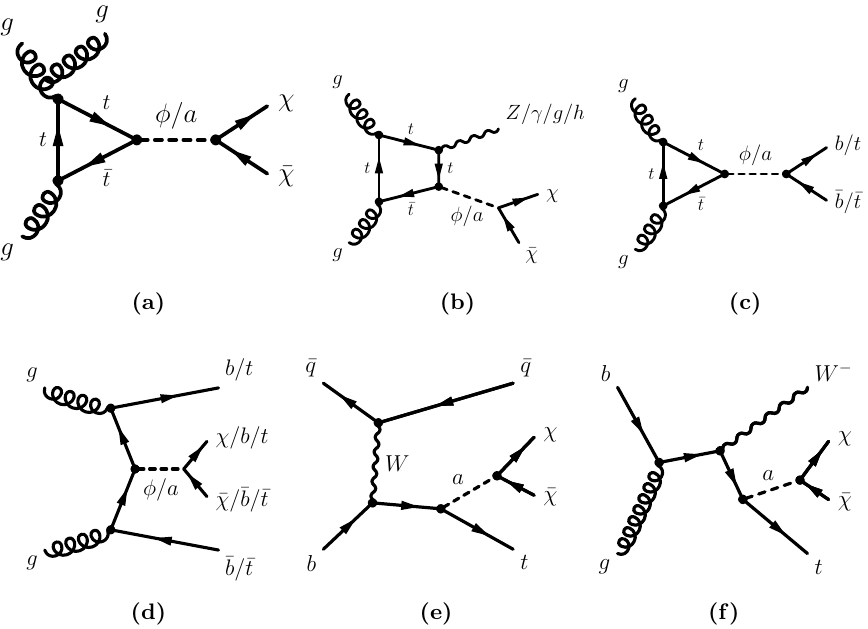
Figure 3. Schematic representation of the dominant production and decay modes for the S/PS